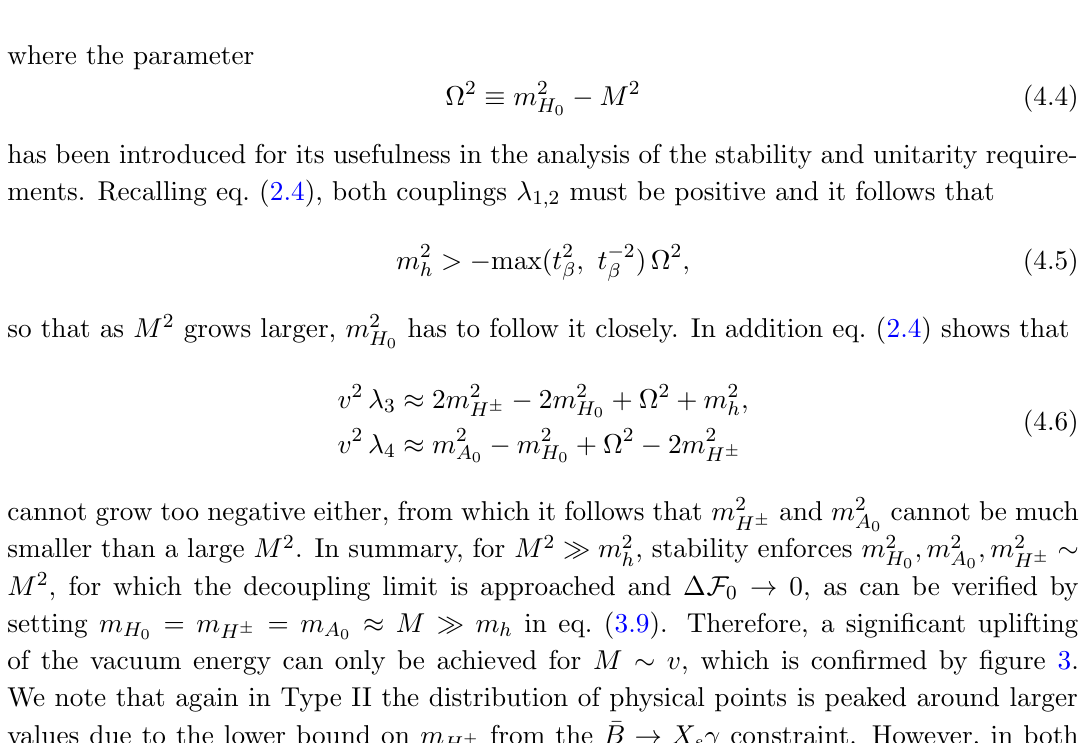
SM = ; m A ) plane. 0 0 F 0 F